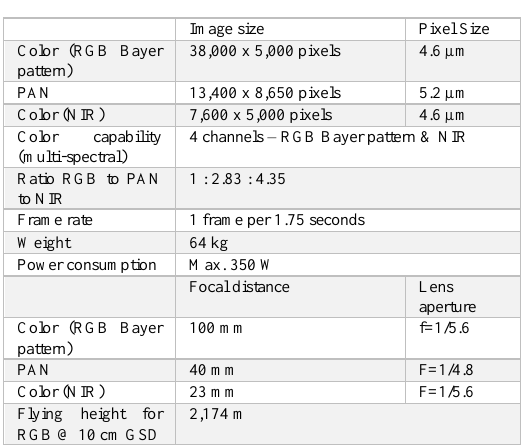
Table 1: Key parameters of UltraCam Condor